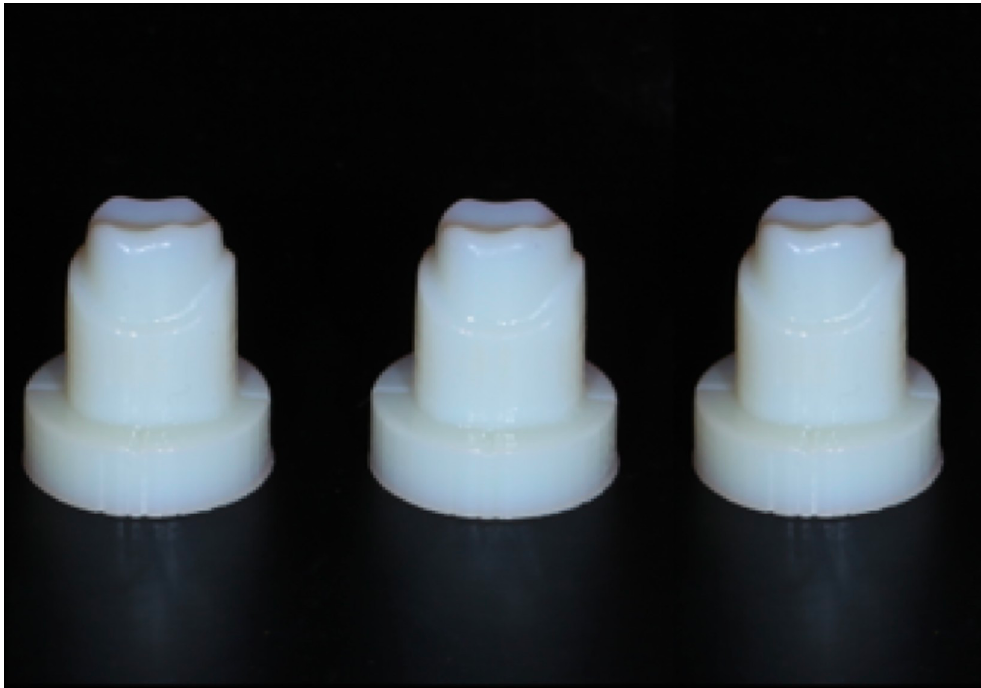
Fig 1. Three-dimensional printed standardized resin abutment models.